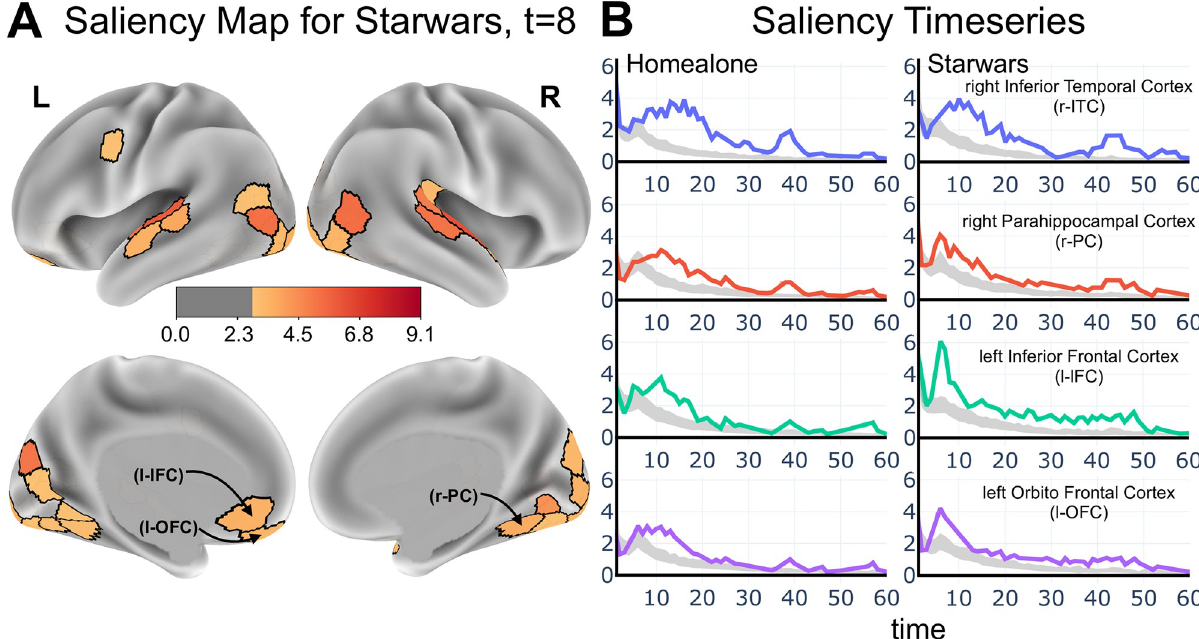
Fig 4. Determining brain contributions to classification. (A) Saliency map for the “Star Wars” clip. For illustration, the top 30 regions are shown. Color scale in arbritary units. See also the video for dynamics. (B) Saliency values for the first 60 seconds of two clips. The gray bands corresponds to the 95-th percentile of null saliency values generated via permutation testing. Scale of the y -axis is arbitrary.